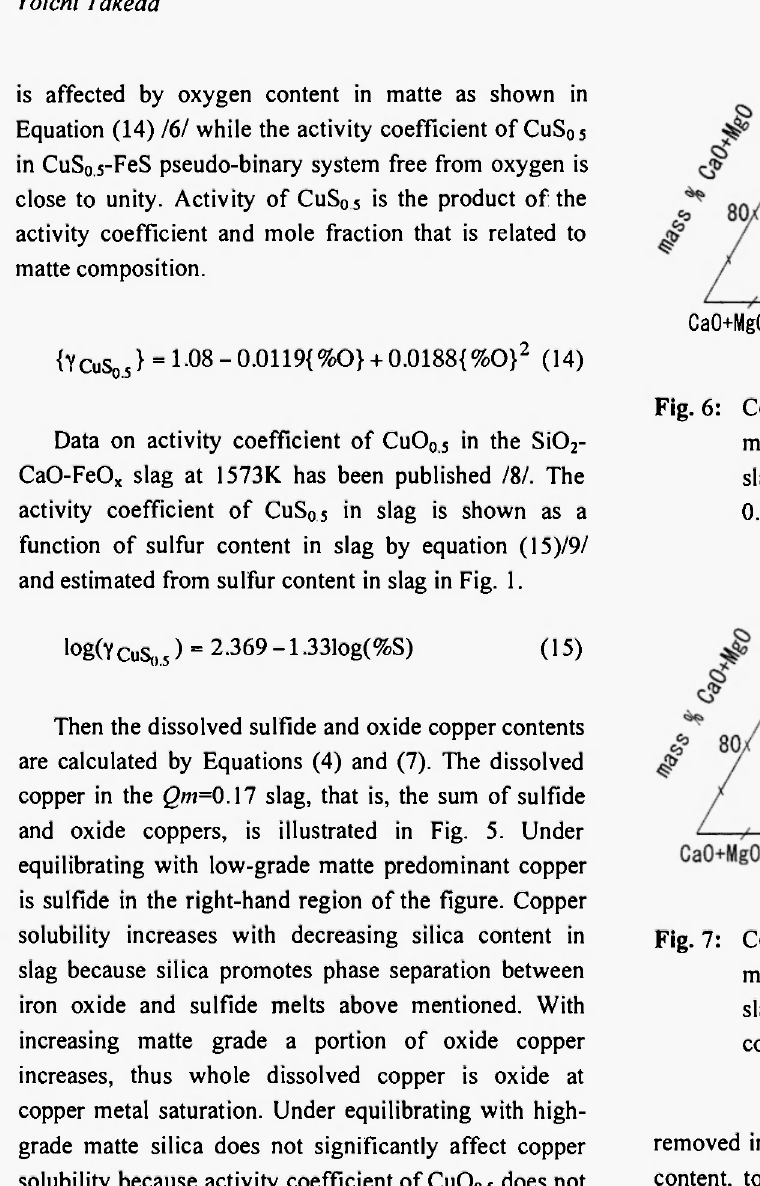
Fig. 7: Copper solubility in Si0 2 -Ca0-Fe0 x slag melted in a magnesia or silica crucible. The slag is equilibrated with 80% copper matte and copper metal at 0.01 MPa S0 2 and 1573K.